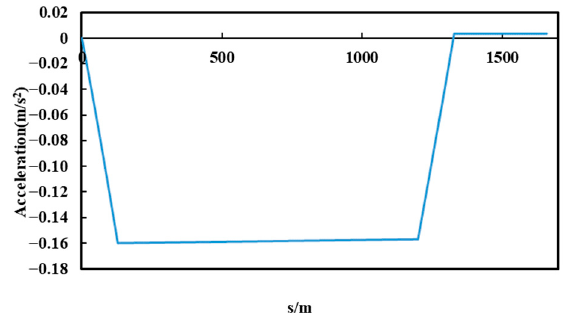
Figure 7. Acceleration of the Maglev train during the fault process.